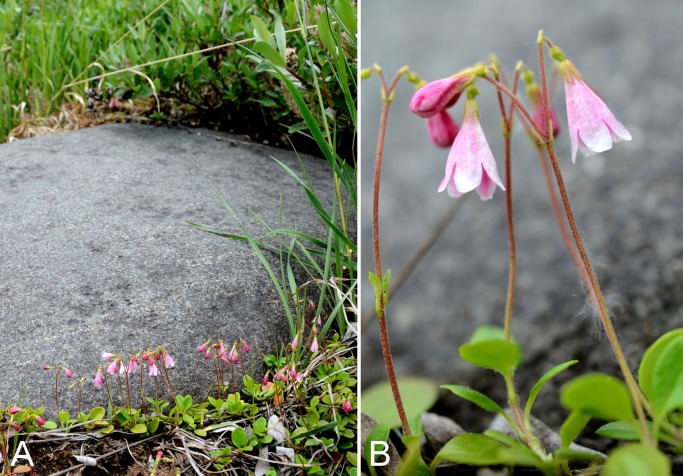
Linnaea borealis subsp. americana.(A) Habit, Saarela et al. 3646. (B) Habit, Saarela et al. 3646. Photographs by R. D. Bull.